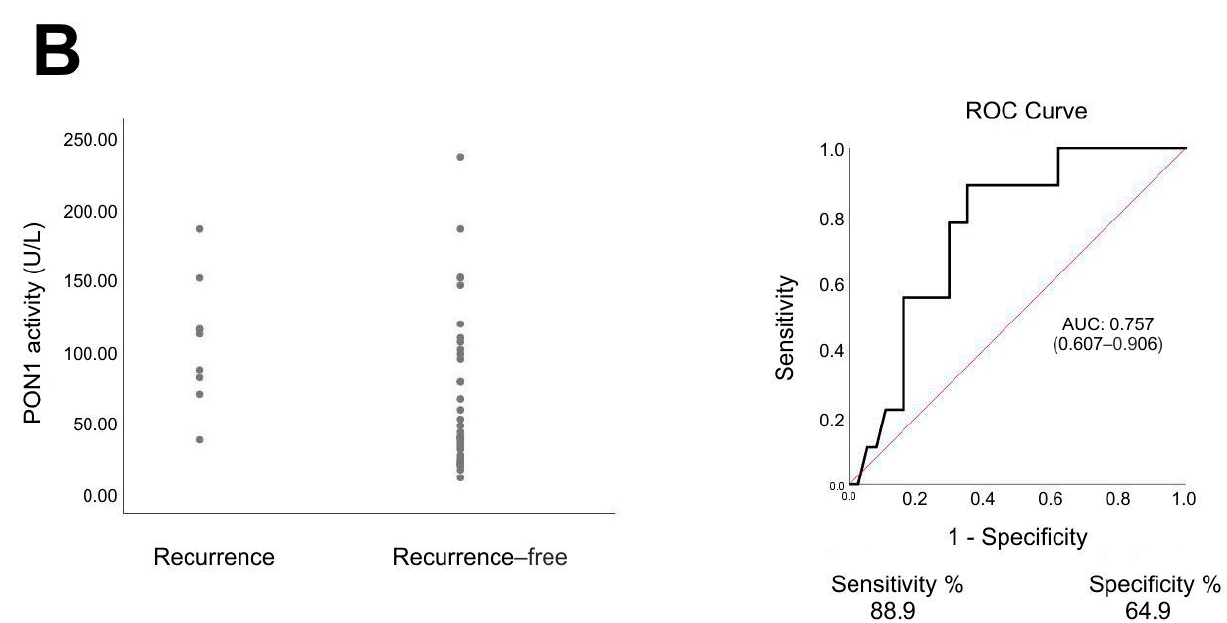
Figure 2. Serum paraoxonase-1 (PON1) activity and receiver operating characteristic (ROC) curves in patients with prostate cancer. ( A ) before radiotherapy, recurrence group vs. recurrence-free group, p = 0.012, Mann–Whitney U test. ( B ) After radiotherapy, recurrence group vs. recurrence-free group, p = 0.017, Mann–Whitney U test.